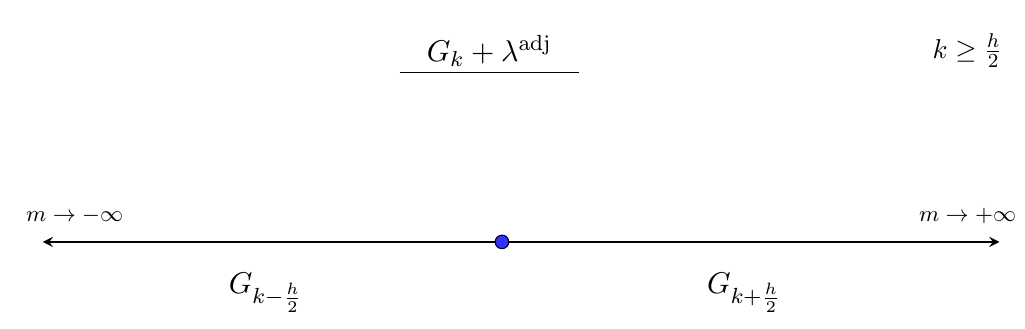
Figure 2 . The proposal of [4] for the Phase diagram of G k gauge theory with a single real adjoint fermion for k (cid:21) h= 2. The solid circle represents a phase transition between the asymptotic